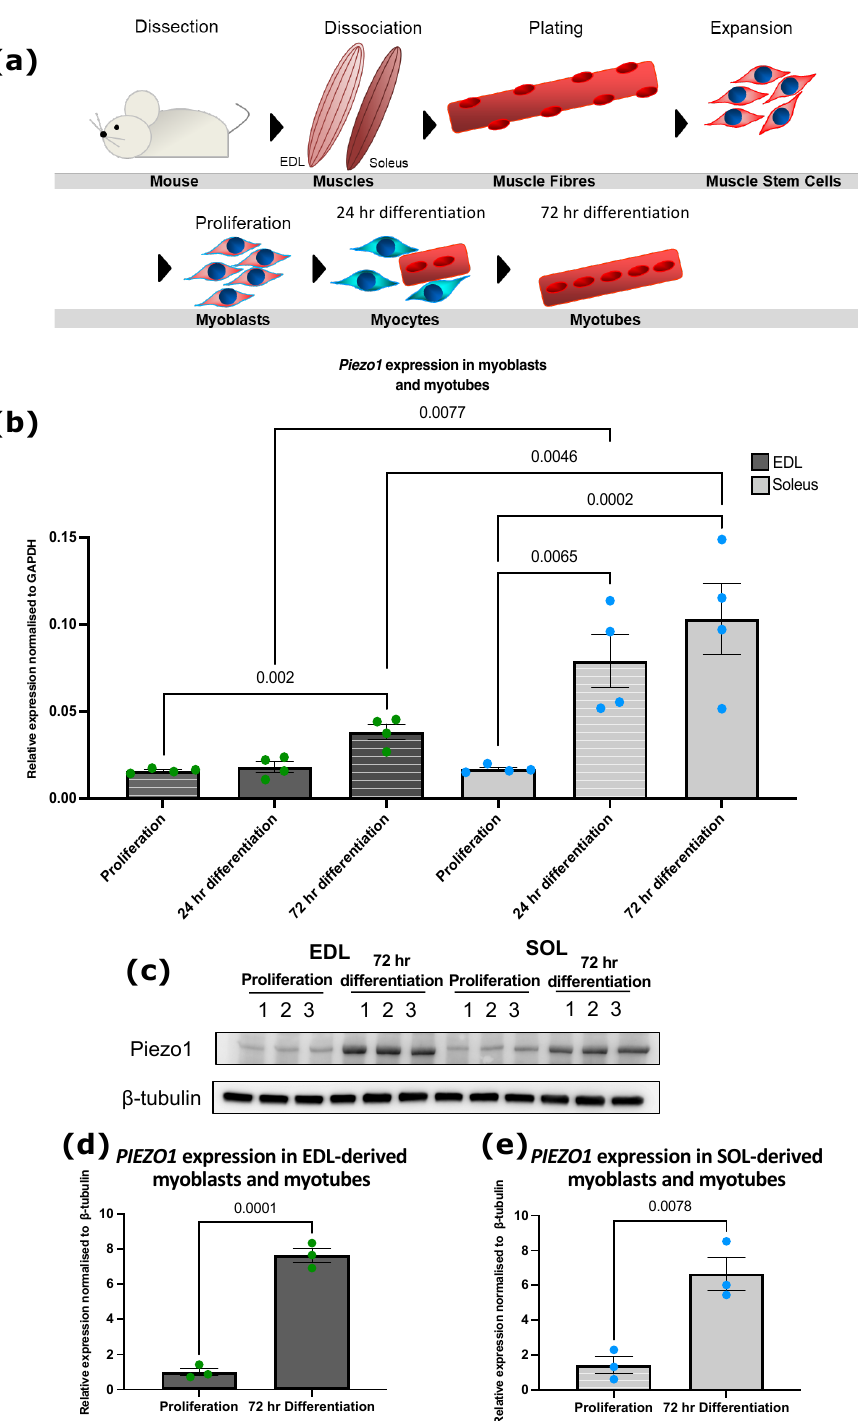
Figure 1. Piezo1 expression increases in differentiating SC-derived myoblast. ( a ) Schematic rep- resentation of muscle isolation and SC-derived myoblast expansion procedure. ( b ) Relative fold changes in expression of Piezo1 in myoblasts from EDL (dark grey bars, green dots) and SOL muscle (light grey bars, blue dots), during proliferation and through differentiation; 24 h (Day 1) and 72 h (Day 3) in differentiation medium. Values were normalised to Gapdh. ( c , d ) Immunoblot analysis for Piezo1 protein in ( d , e ) EDL and I SOL-derived samples in proliferating and differentiated myotubes (72 h differentiation). Values were normalised to β -tubulin. Data are presented as mean ± SEM from four experiments ( n = 3–4 mice). p values are annotated above